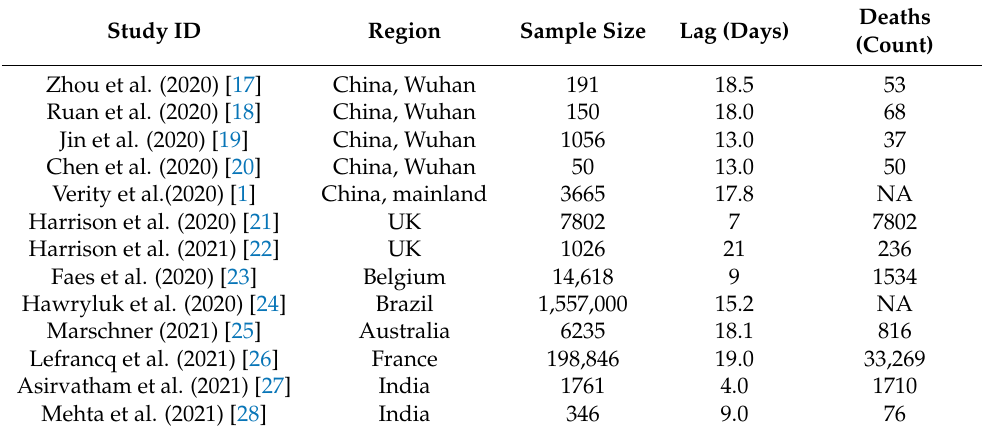
Table 1. Lag from onset of symptoms to death for COVID-19 patients and the total numbers of deaths in each